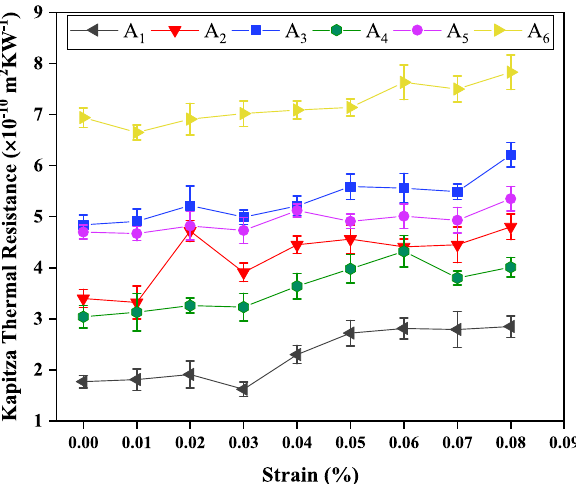
Figure 9. The changes in Kapitza thermal resistance of six constructed grain boundaries A 1 (5–7-6–6-s), A 2 (5–7-6-s), A